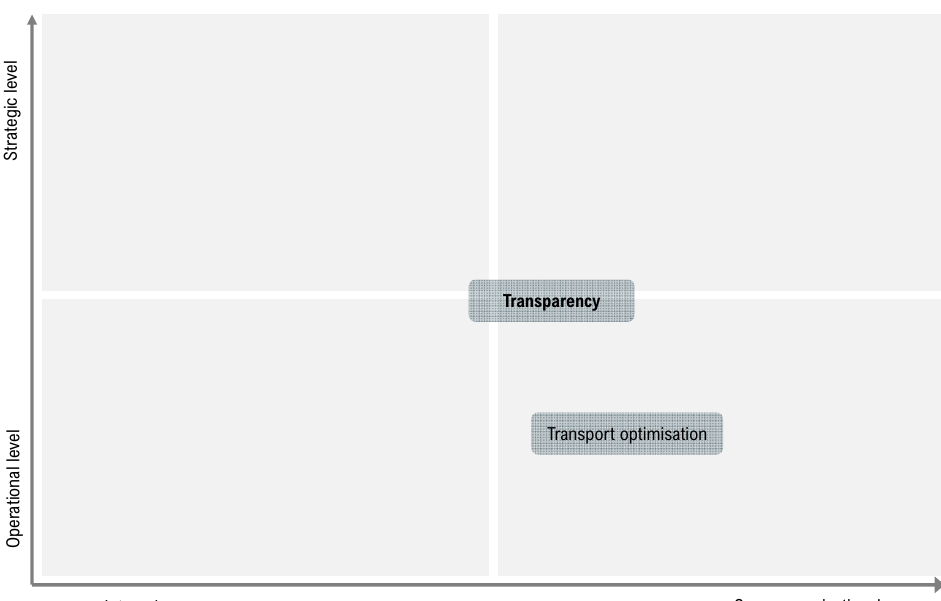
Figure 16. Suggested fields of action for the balanced intermediate profile.